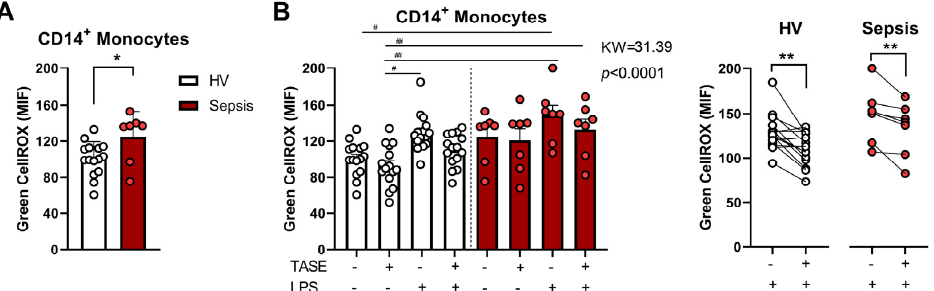
Figure 1. Thiosulfinate-enriched Allium sativum extract (TASE) effects on oxidative stress of monocytes from both HV and septic patients. ( A ) Monocytes from HV ( n = 15) and septic patients ( n = 7) were labeled with Green CellROX. Mean intensities of fluorescence (MIF) on gated CD14 + monocytes determined by flow cytometry are shown. *, p < 0.05 in unpaired t test. ( B ) Monocytes from HV ( n = 15) and septic patients ( n = 7) were stimulated with 10 ng/mL of LPS in the presence or not of 3 µg/mL of TASE for 16 h, then cells were labeled with Green CellROX. MIF on gated CD14 + monocytes determined by fl ow cytometry are shown. KW, Kruskal–Wallis statistic; #, p < 0.05; ##, p < 0.01 in Dunn’s post hoc test. *, p < 0.05; **, p < 0.01 in paired t test. White dots represent individual HV values and red dots individual sepsis values. Bars express mean ± SD. Left panels show indi- vidual paired analyses.